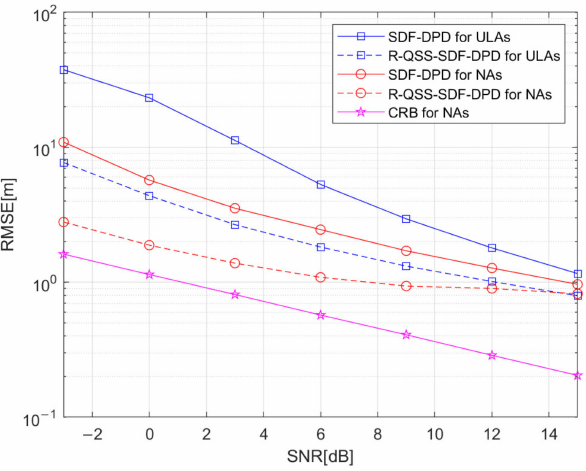
Figure 7. Comparison of SDF-DPD and R-QSS-SDF-DPD algorithms by RMSE versus SNR.